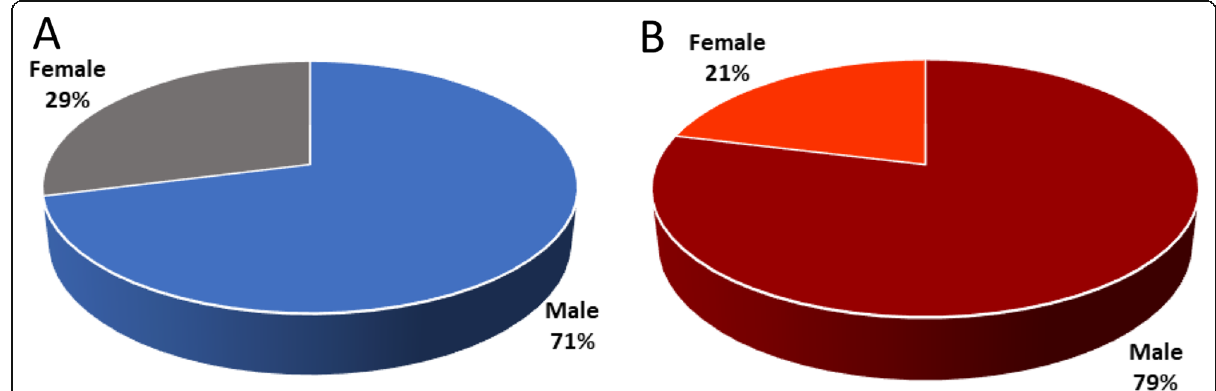
Fig. 4 Percentage by gender in Bangladesh. a Cases. b